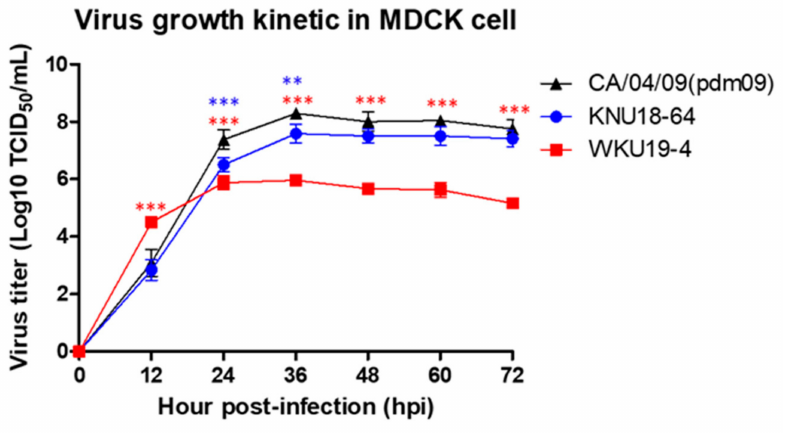
Figure 4. In vitro growth properties of KNU18-64 (A/ Greater white-fronted goose /South Korea/KNU18-64/2018(H1N1)) and WKU19-4 (A/wild bird/South Korea/WKU19-4/2019(H1N1)) in Madin–Darby canine kidney (MDCK) cells. Virus titers were determined by the 50% tissue culture infectious dose (TCID 50 ) assay. The cell monolayers were infected with the viruses at a multiplicity of infection (MOI) rate of 0.01, and incubated for 72 h. Every 12 h, the virus titers were determined by a TCID 50 assay, and an enzyme-linked immunosorbent assay (ELISA) was performed with anti- influenza nucleoprotein to detect infected cells. The virus titers are the means ± standard deviations (SD) (n = 3), **, p < 0.01; ***, p <